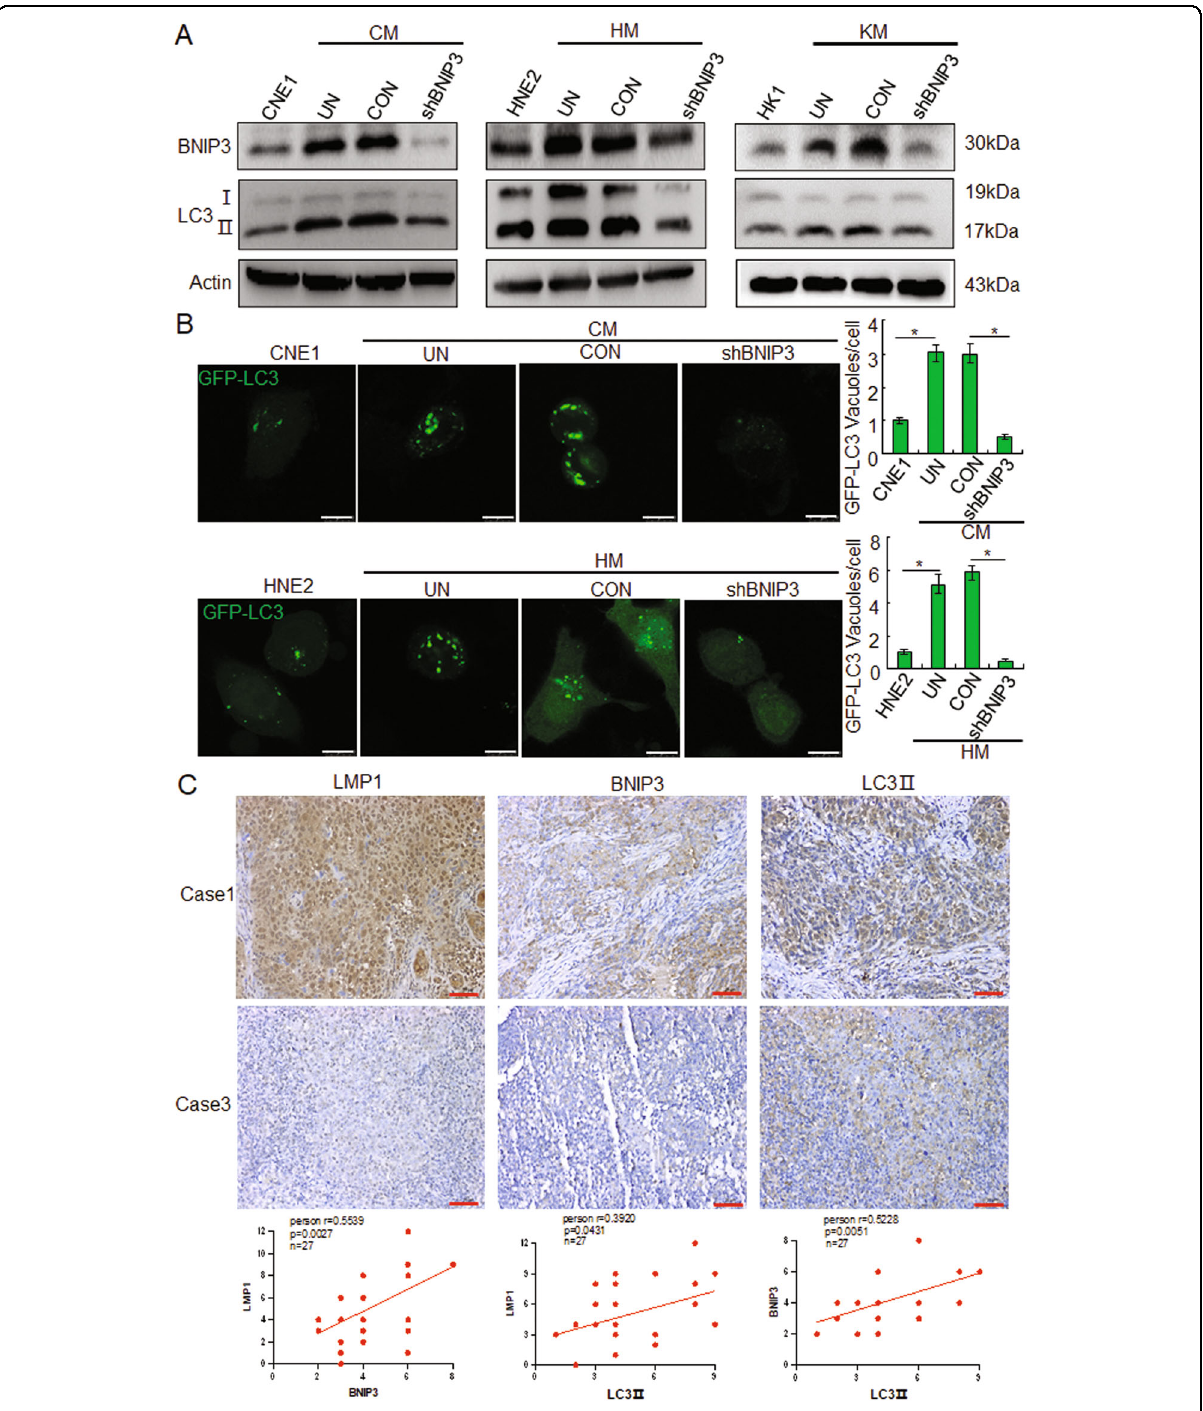
Fig. 3 LMP1 induces autophagy through BNIP3 in NPC cells. A After transfection with shBNIP3 and control for 24 h, the expression of BNIP3 and LC3 І / ІІ in CNE1, CM, HNE2, HM, HK1, and KM cells by Western blots. B After transfection with shBNIP3 and control for 24 h, accumulation of GFP-LC3 puncta in NPC cells, Scale bar: 10 μ m. Data are expressed as means ± S.D. of three experiments. * p < 0.05. C Immunohistochemical analysis was performed to detect the expression of LMP1, BNIP3, and LC3II in NPC patient tissues, and the correlations between LMP1, BNIP3, and LC3II were analyzed. UN untreated, CON negative control, Scale bar: 50 μ